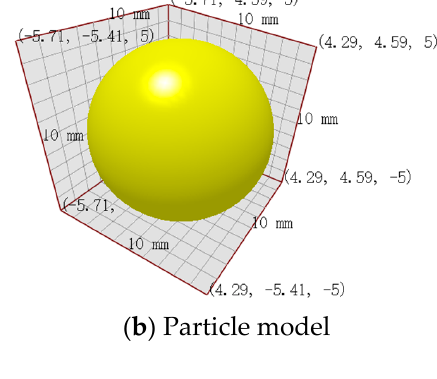
Figure 5. Three-dimensional structure diagram.